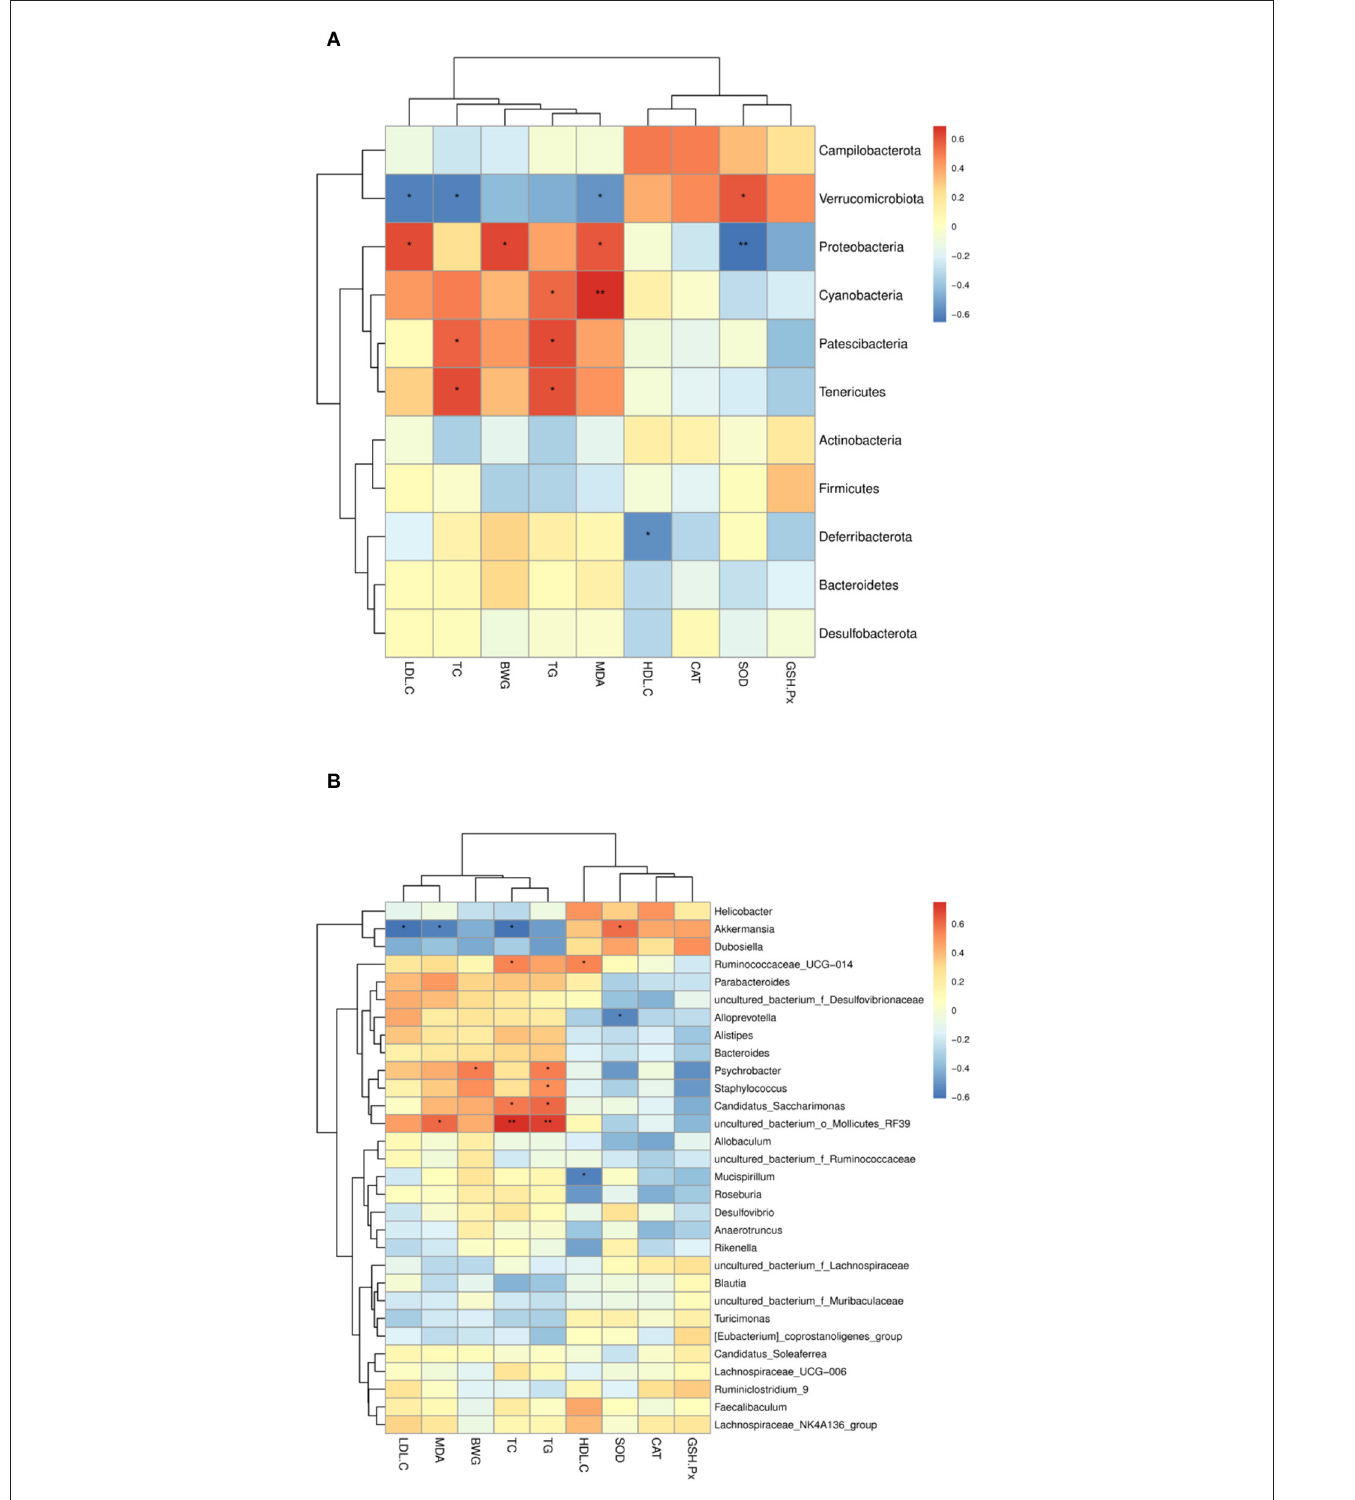
FIGURE 9 | Heatmap of Spearman’s correlation between the intestinal microbiota of significant differences and lipid metabolic parameters. (A) At the phylum level, (B) at the genus level. The intensity of the color representsthe degree of association between the gut microbiota and lipid metabolic parameters (blue represents a negative correlation, whereas red shows a positive correlation). *, represent significant differences ( p < 0.05); **, represent extremely significant differences ( p < 0.01).